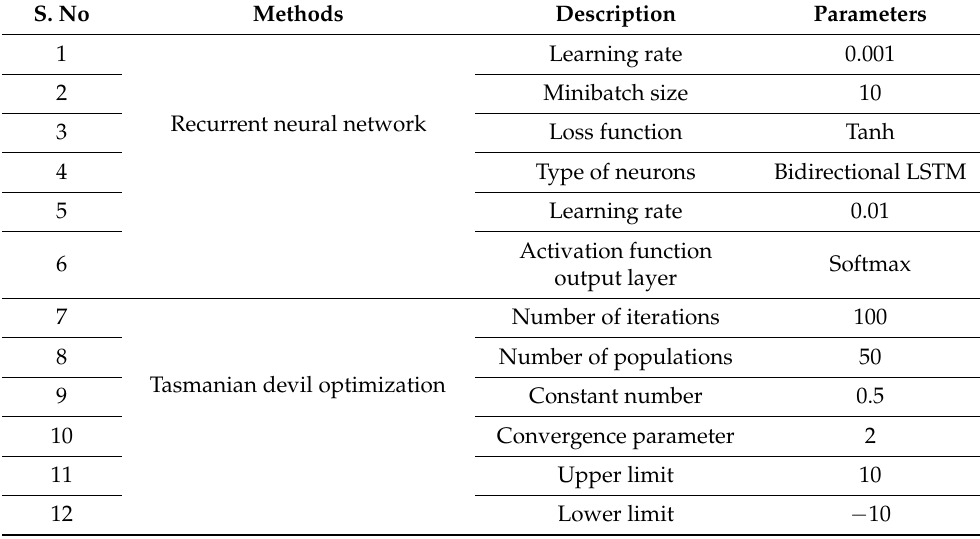
Table 2. Implementation